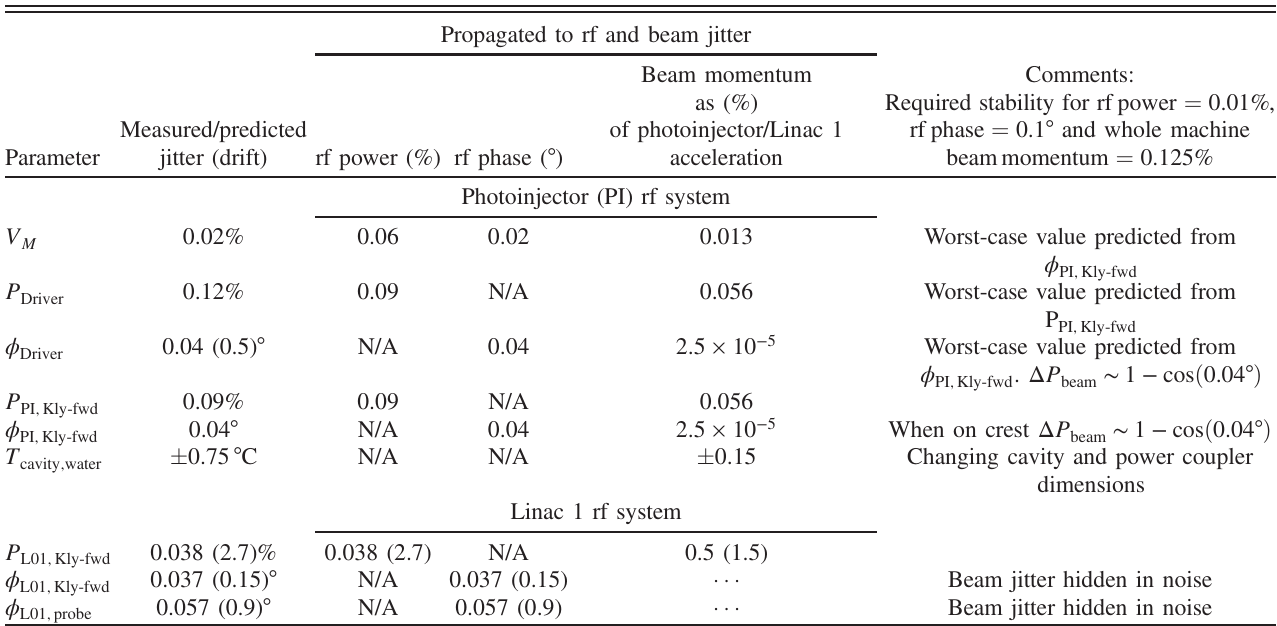
TABLE VIII. Summary of jitter in rf